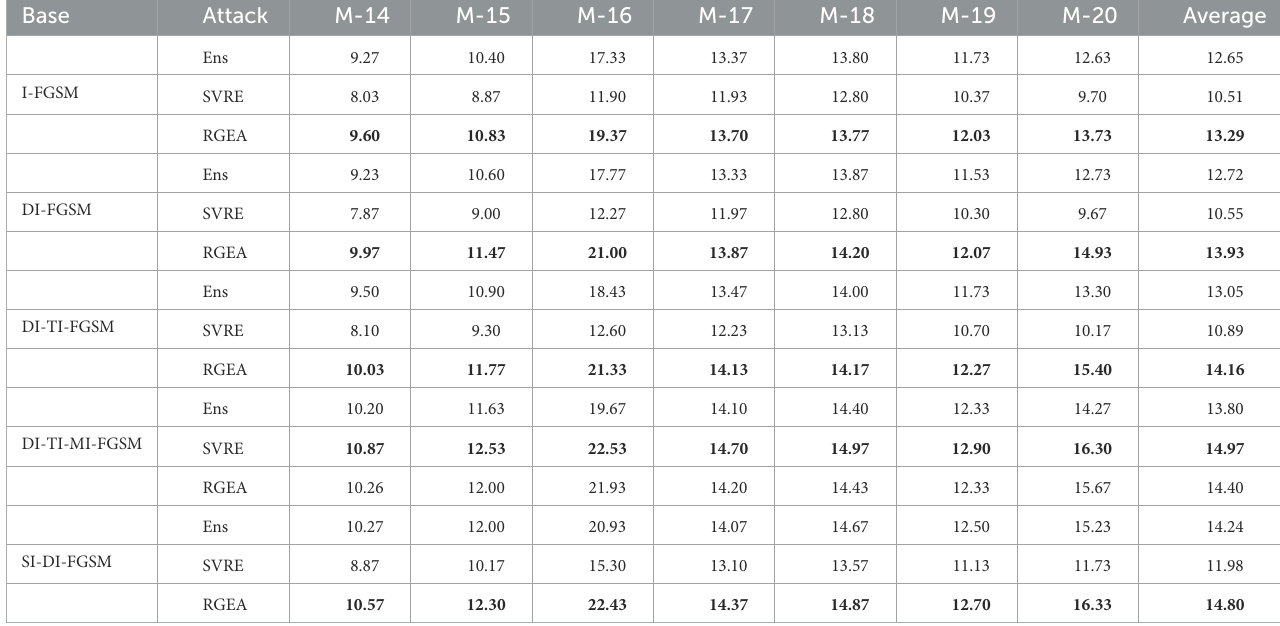
TABLE 4 The black-box attack success rates (%) against seven adversarially trained models.